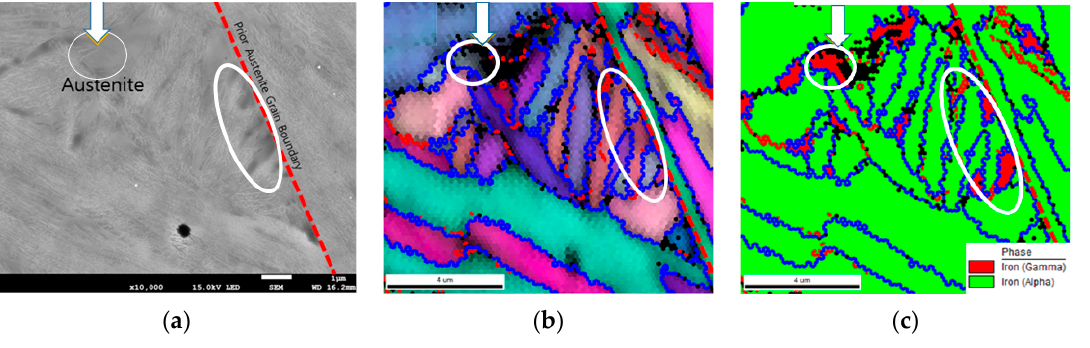
Figure 9. Scanning electron microscopy (SEM) image ( a ) and EBSD maps ( b , c ) of the parts in Figures 7 and 8. ( b ) IPF map combined with an IQ map of the same region with ( a ). ( c ) Phase map of ( b ). The red and green colors indicate the FCC and BCC phases, respectively .